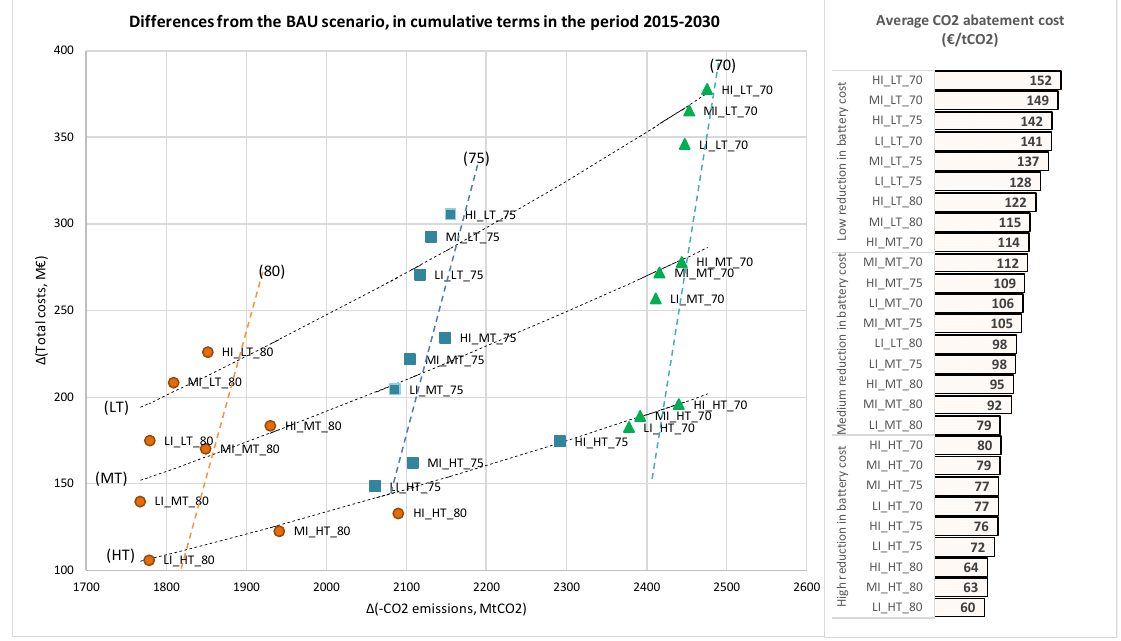
Figure 10. (left-hand side): CO 2 emission abatement versus change in total transport costs from BAU, for the EU cumulatively in 2015–2030; (right-hand side): Average cost of CO 2 emissions abatement relative to the BAU. Notes: Line (LT) group cases with low reduction in battery costs, line (MT) for a medium reduction in battery costs, line (HT) for a high reduction in battery costs. Line (80) groups cases with a standard at 80 gCO 2 /km, line (75) for a standard at 75 gCO 2 /km and line (70) for a standard at 70 gCO 2 /km.